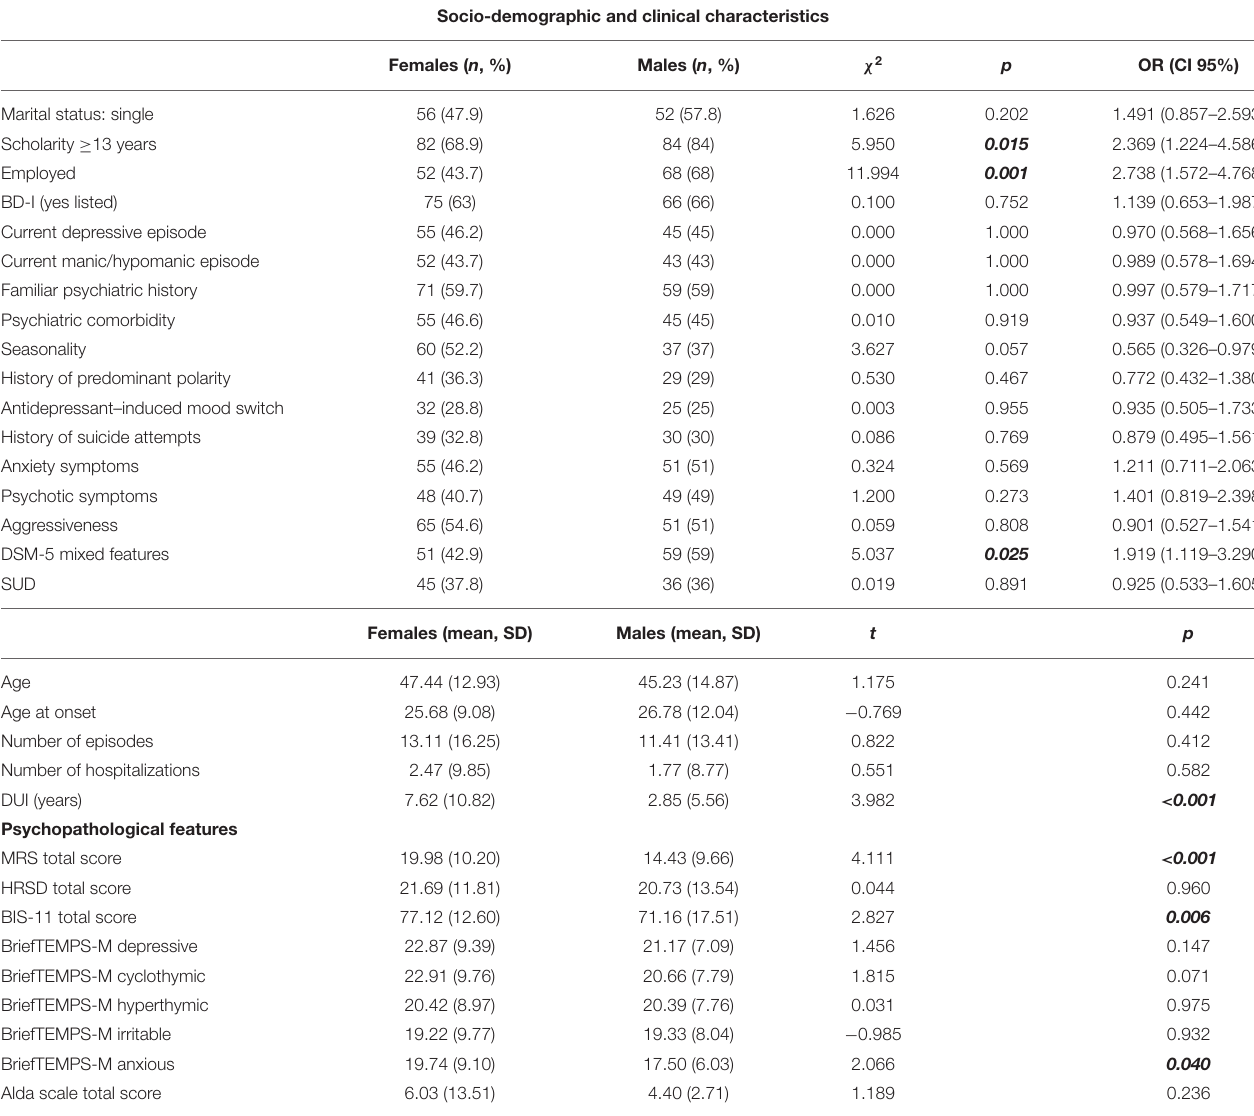
TABLE 1 | Comparison of socio-demographic, clinical, and psychopathological characteristics between females ( n = 119, 54.3%) and males ( n = 100, 45.7%) in our sample. Socio-demographic and clinical characteristics Females ( n ,